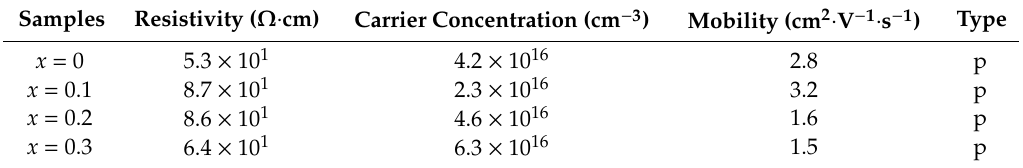
Table 2. Electrical properties of the Cu 2 Mn x Zn 1 − x Sn(S,Se) 4 (0 ≤ x ≤ 0.3) thin films measured by Hall e ff ect